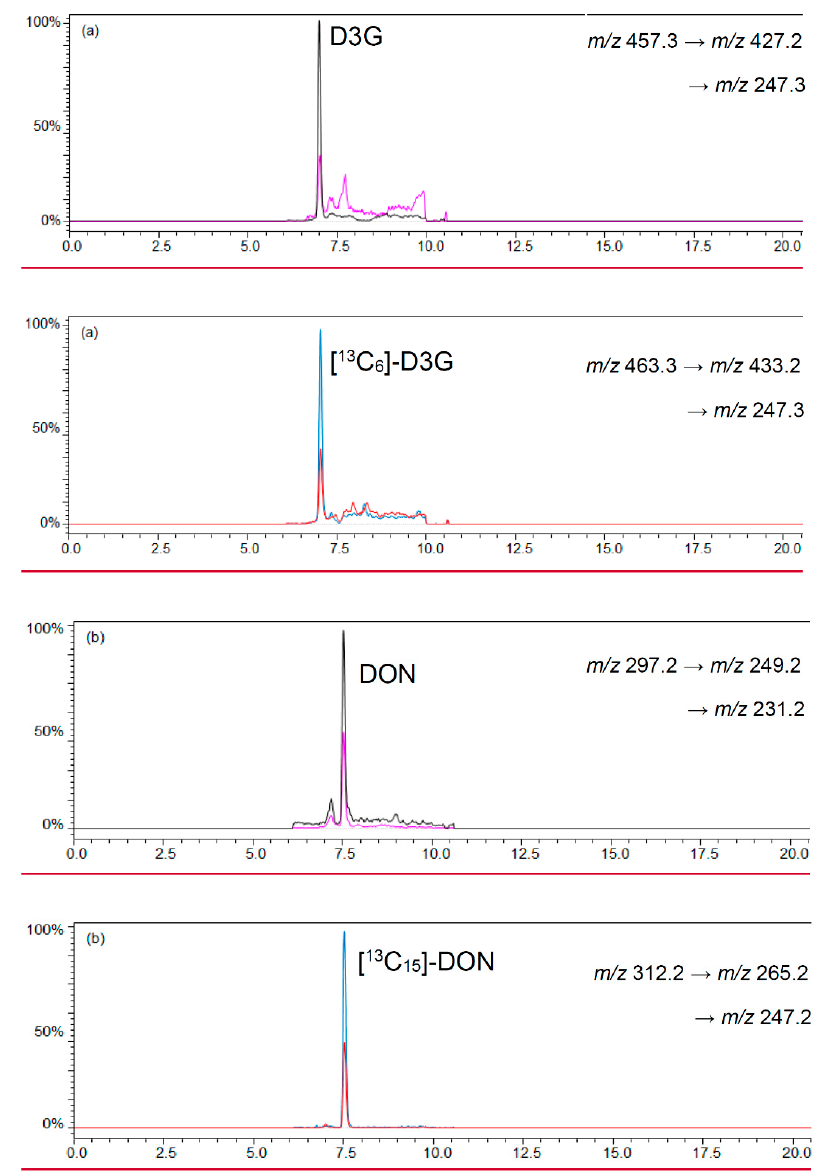
Figure 3. LC-MS/MS chromatograms of ( a ) D3G in negative ESI mode; and ( b ) DON in positive ESI mode in a naturally-contaminated beer sample with 10.6 μ g/L D3G and 20.3 μ g/L DON.